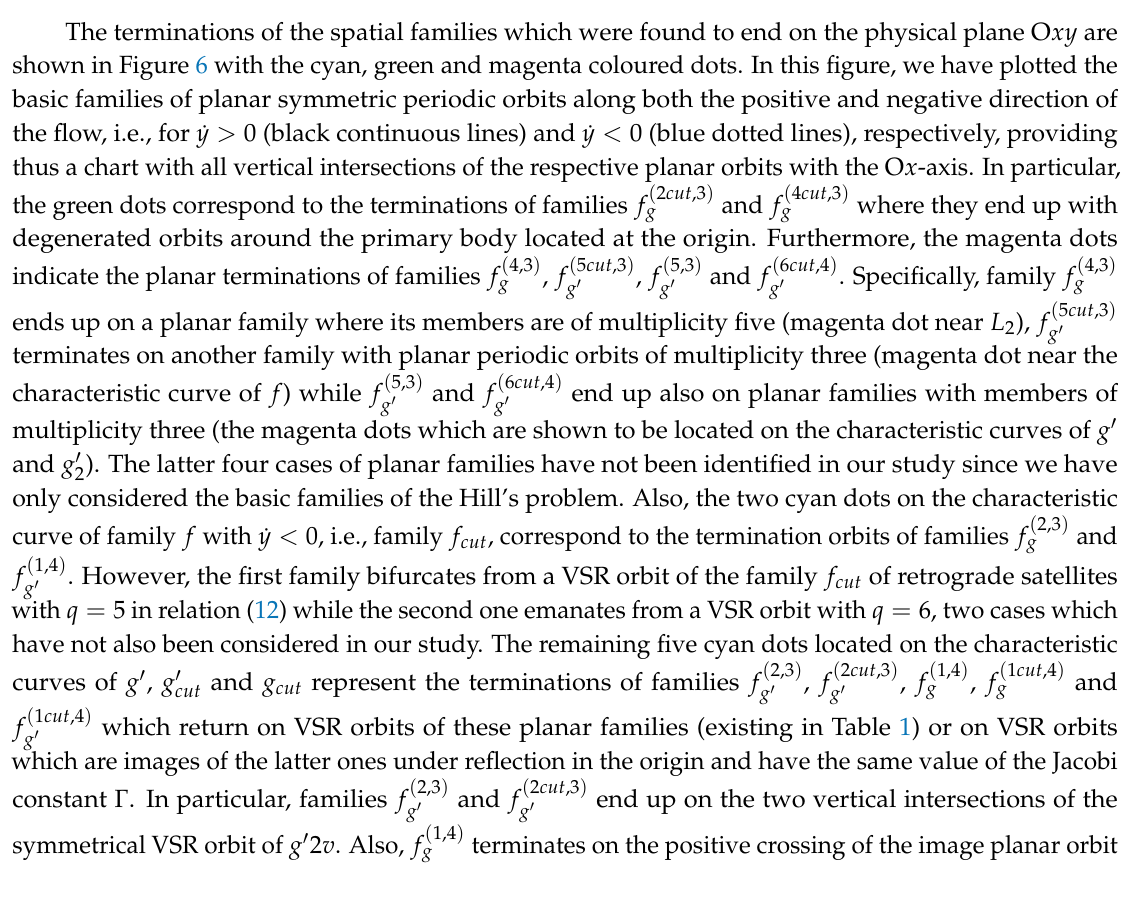
Figure 5. 3D families bifurcating from the VSR orbits g (cid:48) i v , i = 1,2,5,6,9,10 of family g (cid:48) . ( a ) Bifurcating families starting from the initial condition ( Γ 0 , x 0 ) of the planar family and ( b ) Bifurcating families starting from the initial condition ( Γ 0 , x cut ) of the planar family. Grey star indicates that a family goes to collision